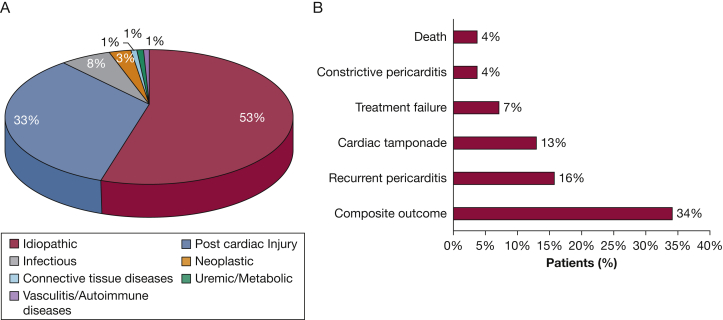
A, Etiology of acute pericarditis. The pie chart shows the prevalence of various acute pericarditis etiologies in the cohort. B, Adverse outcomes. The column chart shows the incidence of adverse outcomes in the cohort.